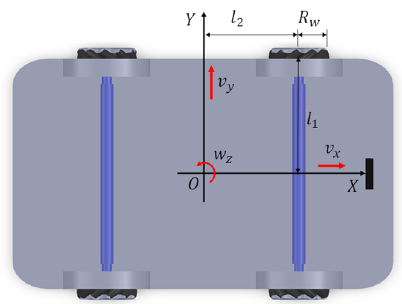
Figure 2. Coordinate systems for a Mecanum wheel-based mobile robot platform.